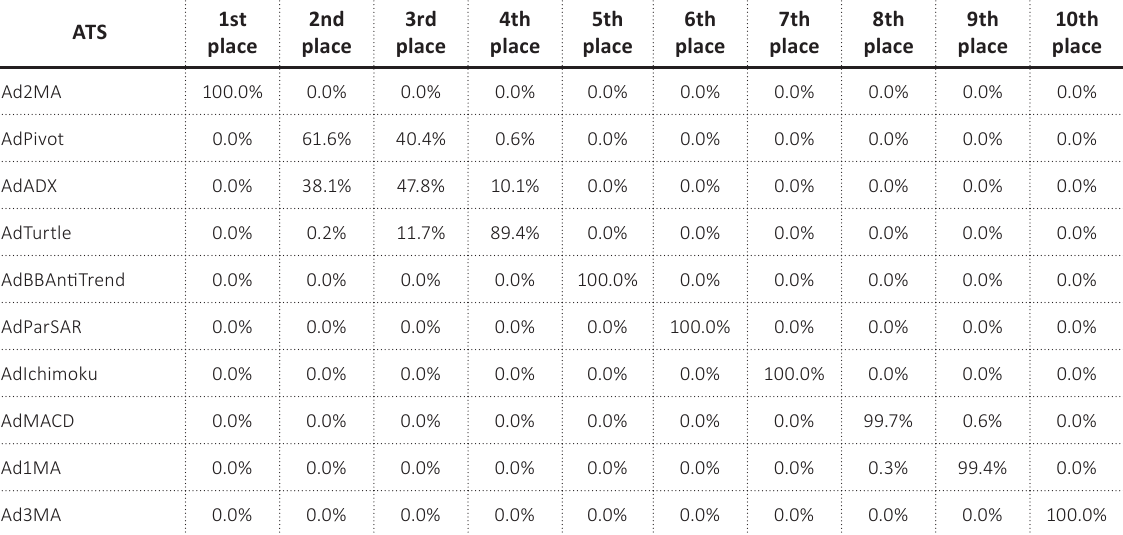
Table 1. Classification occurrences for all systems based on the WM values for d-Backtest PS method